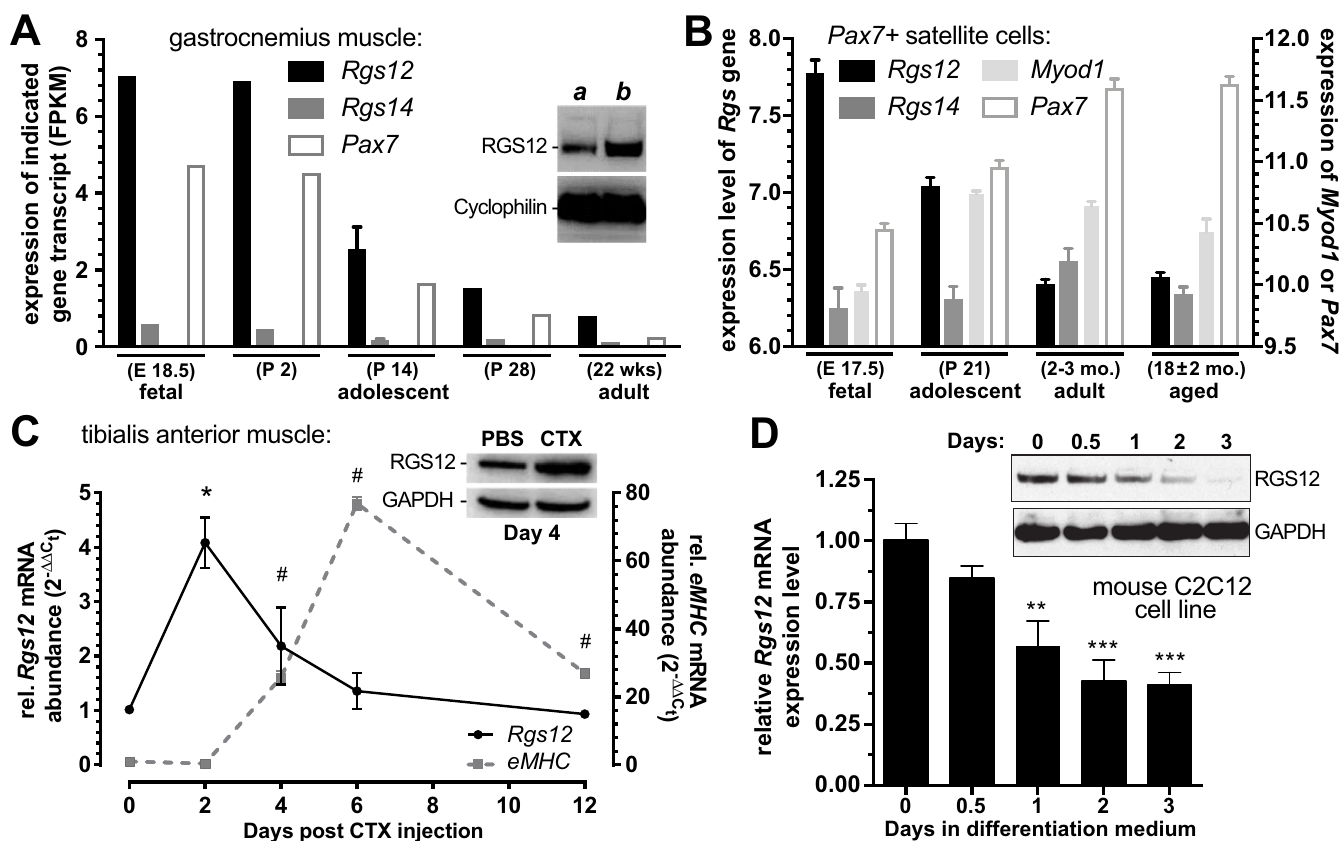
Fig 1. Rgs12 expression is high in mouse embryonic skeletal muscle and active satellite cells, upregulated early during muscle repair, and downregulated upon differentiation of the myoblastic C2C12 cell line. (A ) Relative expression (mean ± SEM of Fragments Per Kilobase of transcript per Million mapped reads [FPKM]) of Rgs12 , Rgs14 , and Pax7 gene transcripts within indicated ages of mouse gastrocnemius muscle samples was obtained via RNA-Seq using an Illumina HiSeq 2000. Based on Gene Expression Omnibus dataset GSE108402 [50]. Inset , detection of RGS12 protein expression via immunoblotting of ( a ) 100 μ g of whole gastrocnemius muscle lysate from a 3-month-old C57BL/6J mouse and ( b ) 50 μ g of lysate from myoblasts isolated from cardiotoxin-injected tibialis anterior (TA) muscle. (B) Normalized expression levels (mean ± SEM) of Rgs12 , Rgs14 , and Pax7 gene transcripts within indicated ages of flow-sorted, Pax7 + mouse skeletal muscle satellite cells were obtained via an Affymetrix Mouse Gene 1.0 ST microarray, based on Gene Expression Omnibus dataset GSE47401; published in [51]. (C) Relative expression of Rgs12 and eMHC in TA muscle following CTX-induced muscle damage. RNA was extracted from muscle at the indicated time points and quantified using qRT-PCR, with Gapdh abundance as an internal control. � , p < 0.01 Rgs12 level compared to time zero (one-way ANOVA with Dunnett’s test); #, p < 0.0001 eMHC level compared to time zero (one-way ANOVA with Dunnett’s test). Inset , TA muscle was injected with 0.1 ml of 10 μ M cardiotoxin (CTX) diluted in PBS; contralateral, PBS-injected TA muscle was used as a control. After four days, the muscles were harvested and used for RGS12 protein expression analysis by immunoblotting (with GAPDH protein levels interrogated in parallel as a loading control). (D) C2C12 cell line cultures (4 x 10 5 cells/well) were maintained in growth medium (DMEM containing 10% fetal bovine serum [FBS]) for two days. Differentiation was induced by replacing growth medium with differentiation medium (DMEM containing 2% horse serum [HS] instead of FBS). Total RNA and protein lysates were separately isolated from cell cultures at the indicated time points (hours) after the switch to differentiation medium. Rgs12 mRNA and RGS12 protein levels were determined by qRT-PCR and immunoblotting, respectively. GAPDH mRNA and protein levels were used as internal controls for each experiment. �� , p < 0.01; ��� , p < 0.001 versus level observed at time zero (one-way ANOVA with Dunnett’s test).